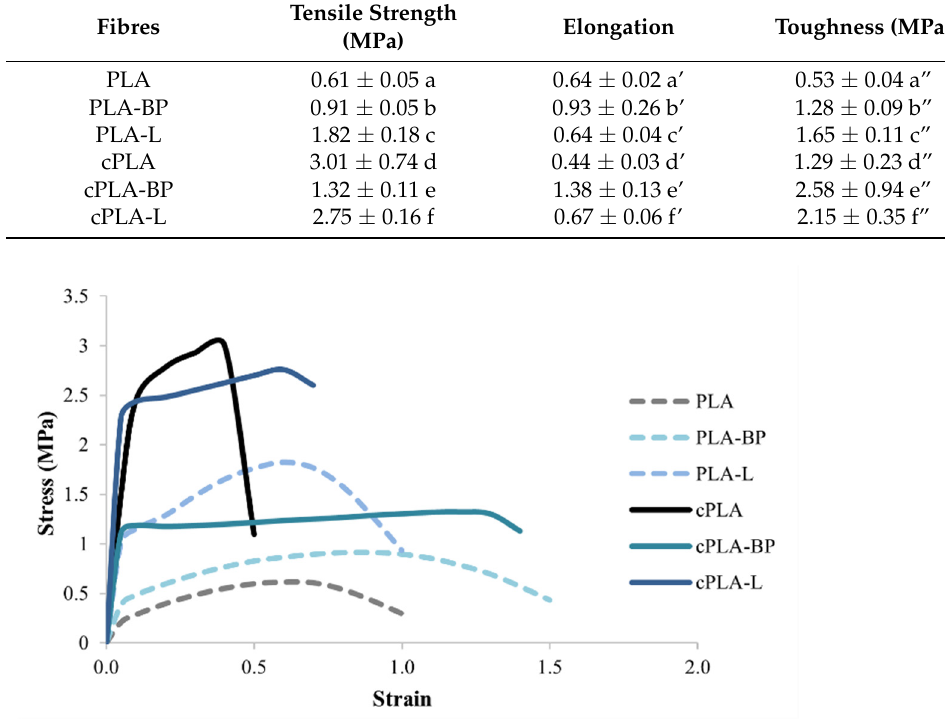
Figure 4. Average stress-strain curves of uncoated (PLA, PLA-BP and PLA-L) and coated (cPLA, cPLA-BP and cPLA-L) fibres (mean value ± s.e.; n = 3).